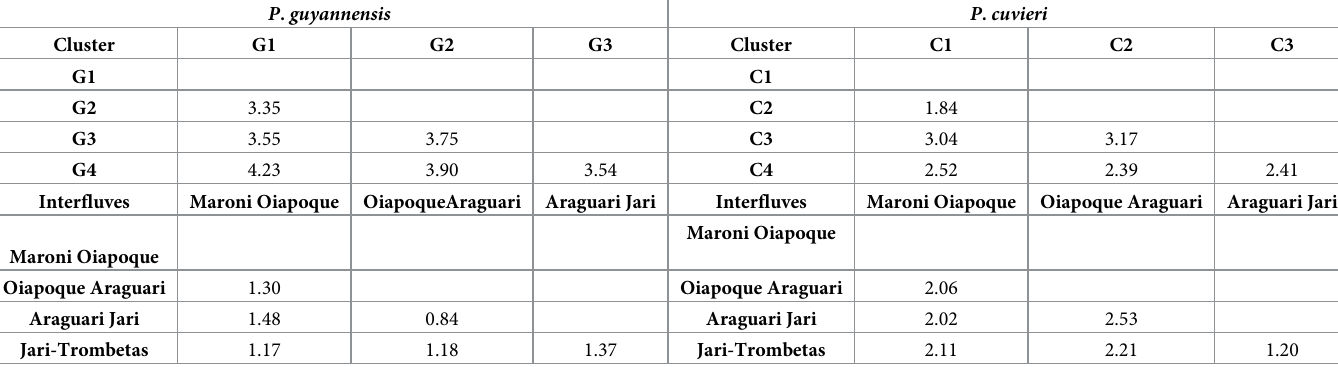
Table 2. Matrix of the genetic distances (p-distance), based on the sequences of the cytb gene. We compare values from the clusters defined by the BAPS: P . guyannen- sis (G1, G2, G3, G4) and P . cuvieri (C1, C2, C3, C4). We compare between the interfluves of the study region: Maroni-Oiapoque; Oiapoque-Araguari; Araguari-Jari e Jari-